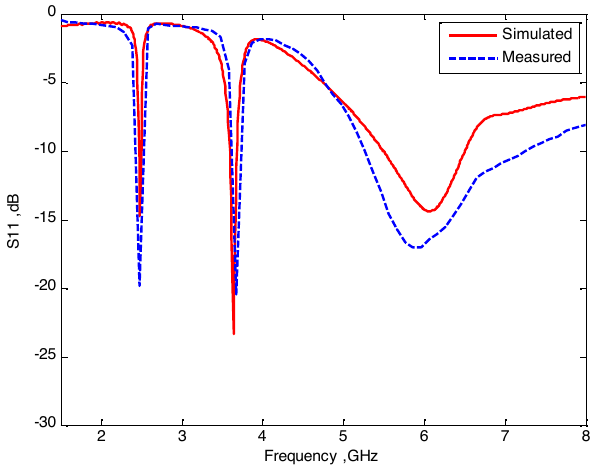
Fig.12 Simulated and measured S 11 for proposed antenna. Table 2: Comparisons between the proposed antenna and existing antennas Ref.